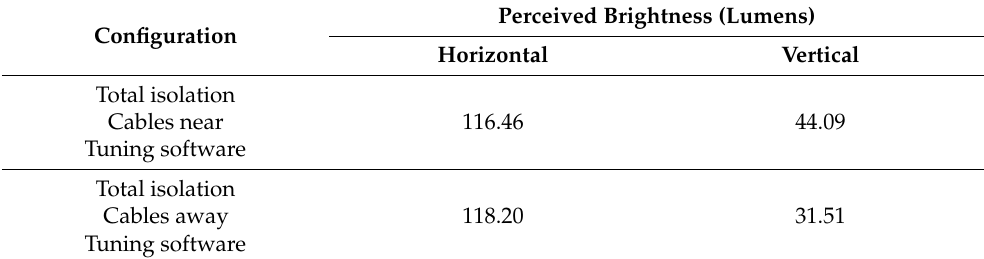
Table 3. Perceived brightness for cumulative